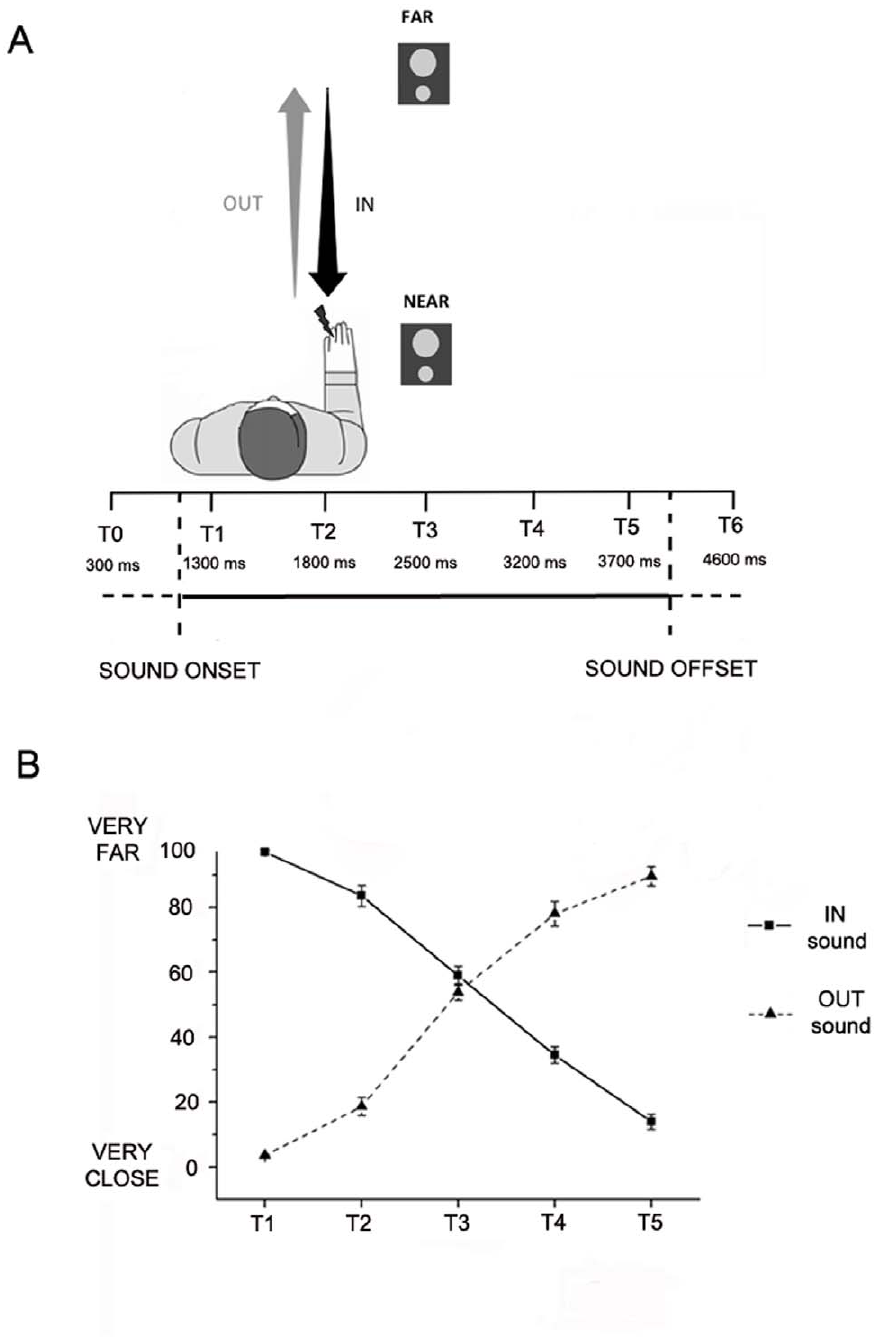
Figure 1. Experimental setup. Panel A. Procedure. Subjects received a tactile stimulus at their hand while task-irrelevant sounds either approached to or receded from the hand. Tactile stimuli were delivered at different temporal delays from sound onset (from T1 to T5), so that they were processed when sounds were perceived at a different distance from the hand. Panel B. S ound localization experiment results. The graph shows subject’s mean responses indicating the perceived position of sound in space when they receive a tactile stimulus at different temporal delays from sound onset, from T1 to T5. Filled line refers to IN sound condition, hatched line refers to OUT sound condition. Error bars denote S.E.M. A repeated measure ANOVA with Sound (IN, OUT) and Temporal Delay (from T1 to T5) confirmed that IN and OUT were perceived as an approaching and receding auditory stimuli, respectively, as clearly shown by the significant two-way interaction (F(4,24)=304.30, p , 0.00001). doi:10.1371/journal.pone.0044306.g001 Taken together, these results suggest that tactile processing is considered as the boundary of PPS representation around the modulated by co-occurrence of dynamic sounds, depending on the hand. In addition, the relationship between the spatial position of position of sounds in space, as far as sounds were perceived at sounds in space and their effect on tactile RTs seems stronger a limited distance from the body, and such distance can be